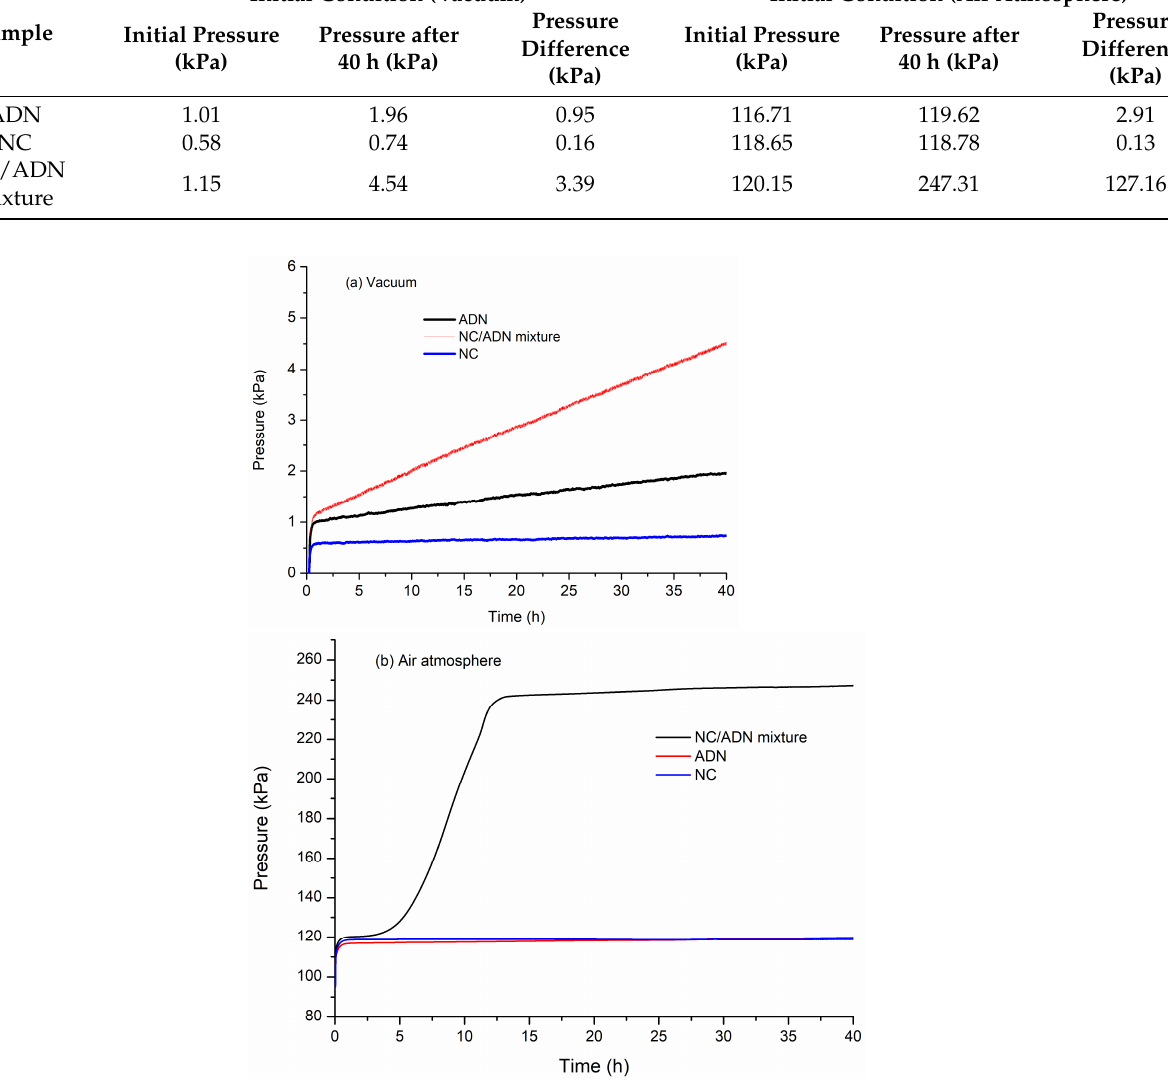
Figure 4. The thermal decomposition gas pressure vs. time curves of ADN, NC and NC/ADN mixture.( a ) Vacuum; ( b ) Air atmosphere. Table 3. Characteristic pressure data of ADN, NC and NC/ADN mixture.